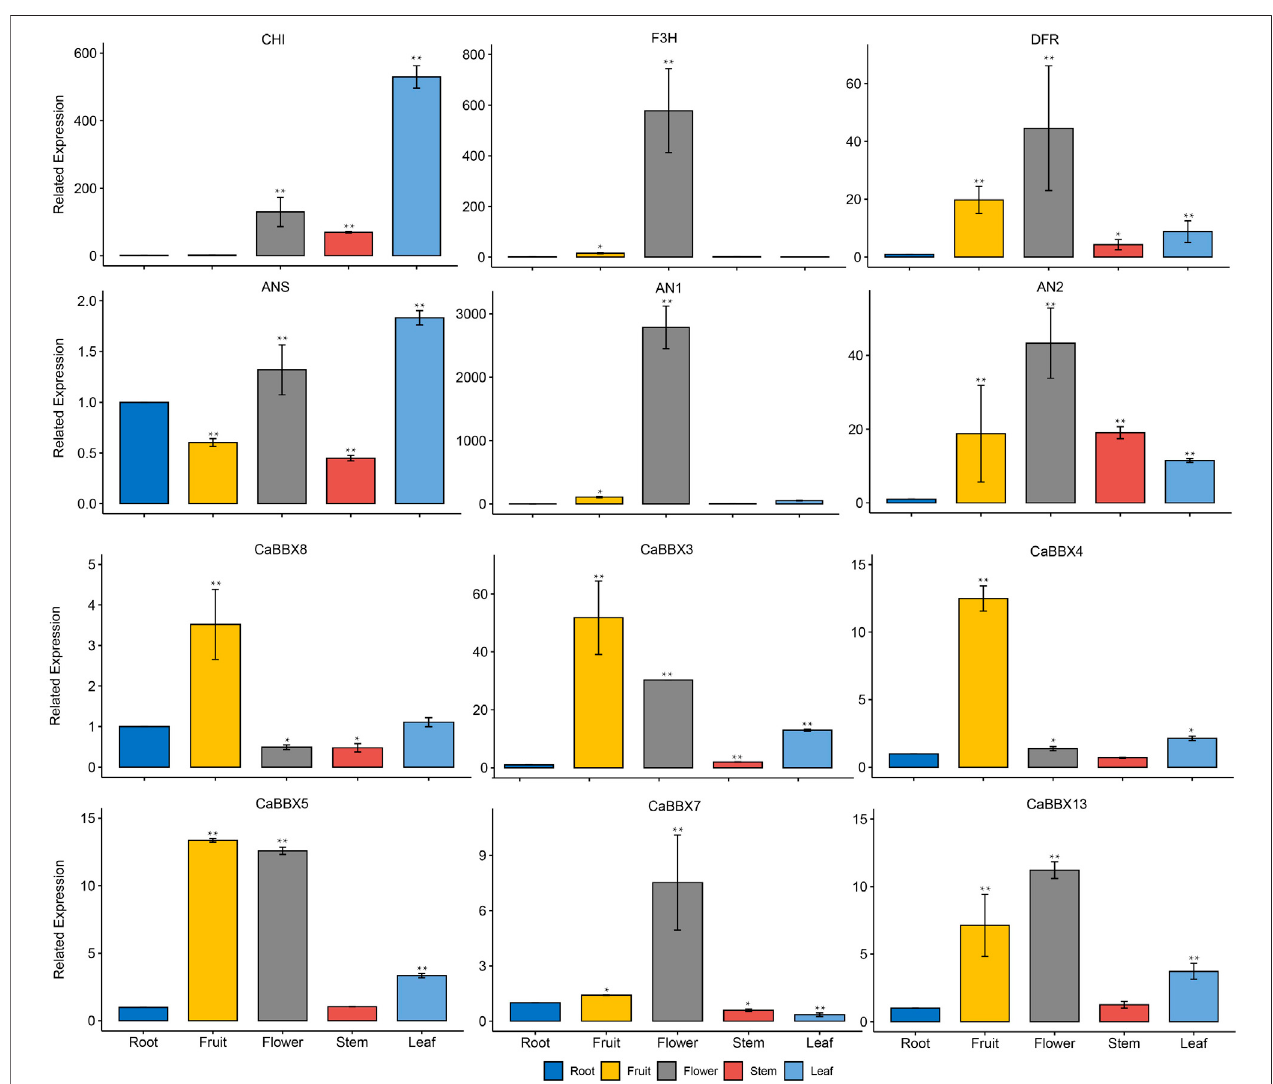
FIGURE6| qRT-PCRanalysisof CaBBXs andthestructuralgenesofanthocyaninbiosynthesispathway.Meanvaluesandstandarddeviations(SDs)areindicated by error bars. Signi fi cant differences were determined by t -test (* p < 0.05, ** p < 0.01, *** p < 0.001).